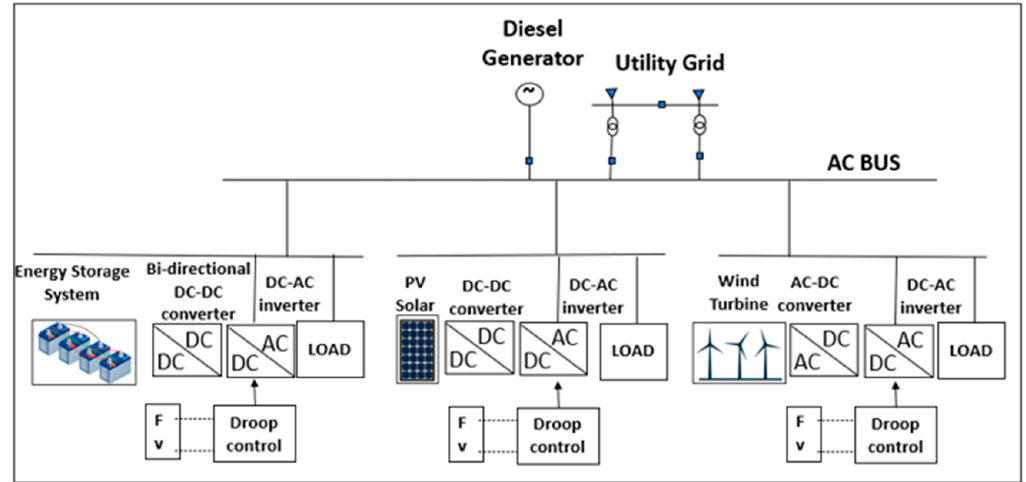
Figure 10. Sample architecture of peer-to-peer (P2P) control in microgrid.